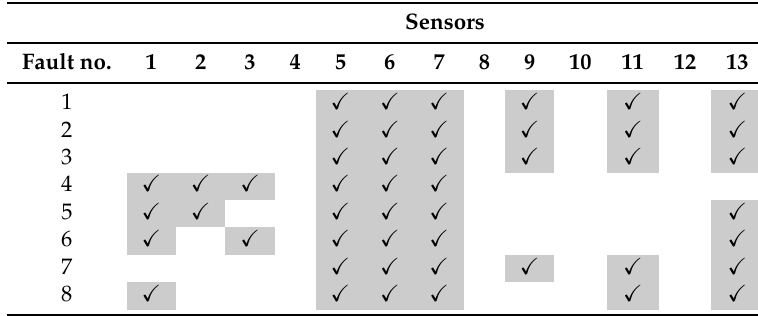
Table 4. Results of the sensor selection when the number of sensors to be combined is σ = 6 for each of the eight fault scenarios described in Table 3. Sensors Fault